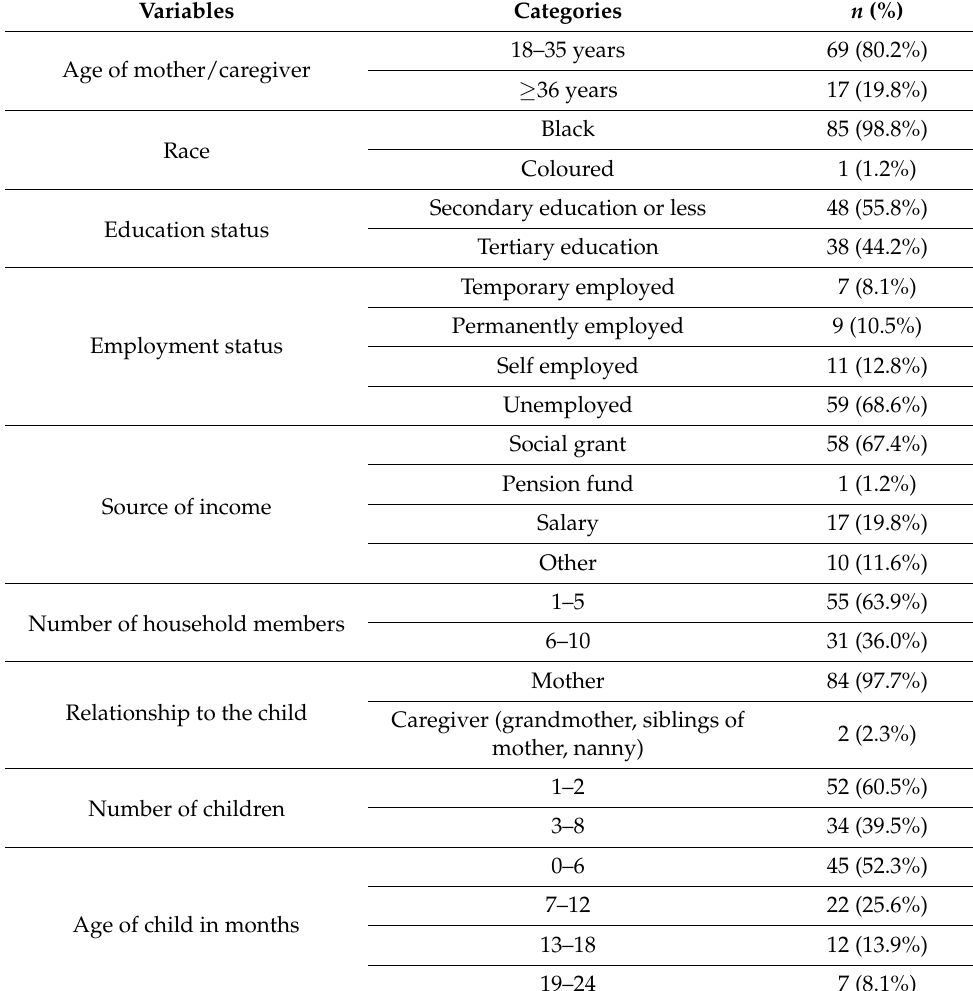
Table 1. Sociodemographic data of participants, % in rows ( n =